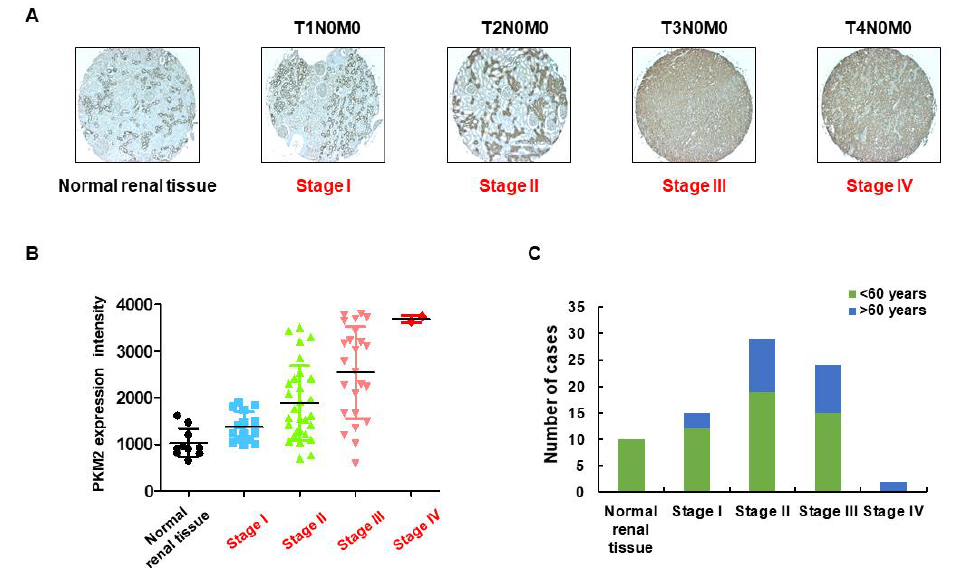
Figure 1. Expression level of pyruvate kinase M2 (PKM2). ( A ) PKM2 protein was immunostained with a specific antibody in normal human kidney tissue and kidney cancer tissue samples and observed under microscopy at 400 × magnification. In comparison with normal kidney tissues, kidney cancer tissues exhibited higher expression levels of PKM2. ( B ) Immunoreactive scoring of PKM2 between human kidney cancer tissue samples (at various tumor stages) and normal kidney tissue samples. ( C ) Number of human kidney cancer tissue samples (at various tumor stages) and normal kidney tissue samples.